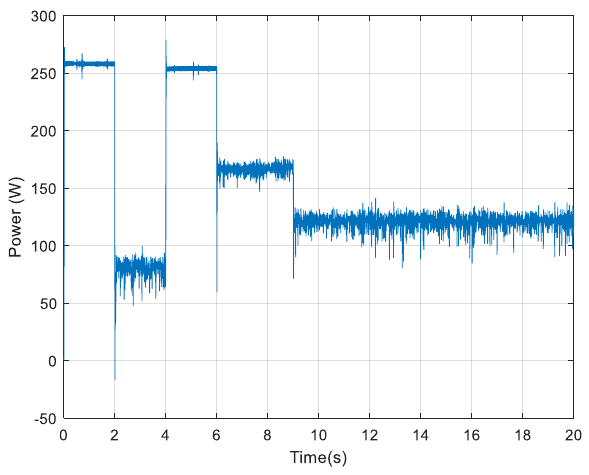
Figure 21. Temporal evolution of the motor power.